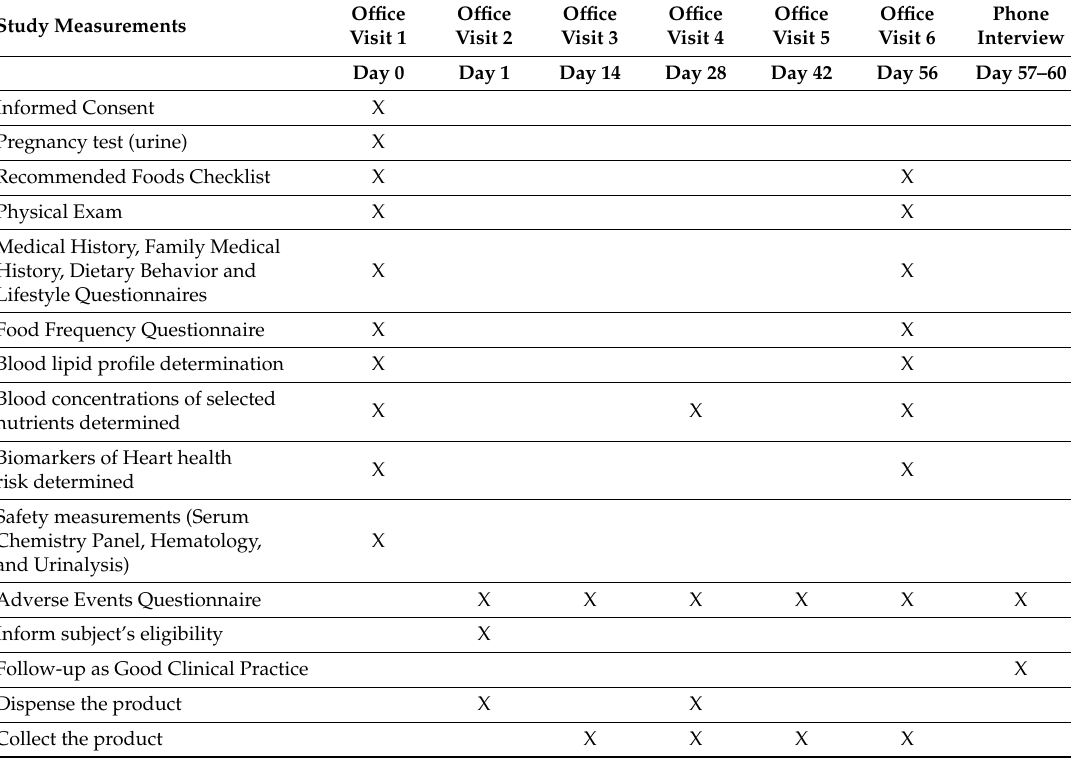
Table 2. Summary of study time line and